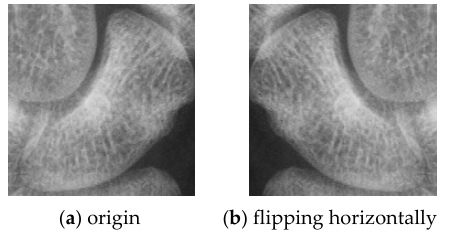
Figure 4. Examples of data augmentation.